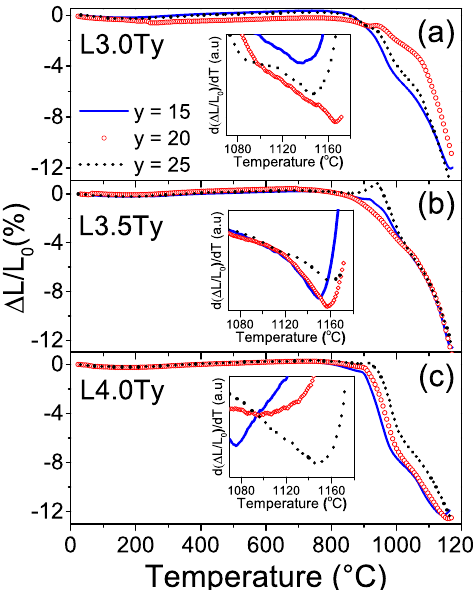
Figure 3. Relative shrinkage and its derivative (inset graphs) as a function of the temperature and Ta content y for the LKNNT powders with compositions ( a ) L3.0Ty, ( b ) L3.5Ty and ( c ) L4.0Ty.